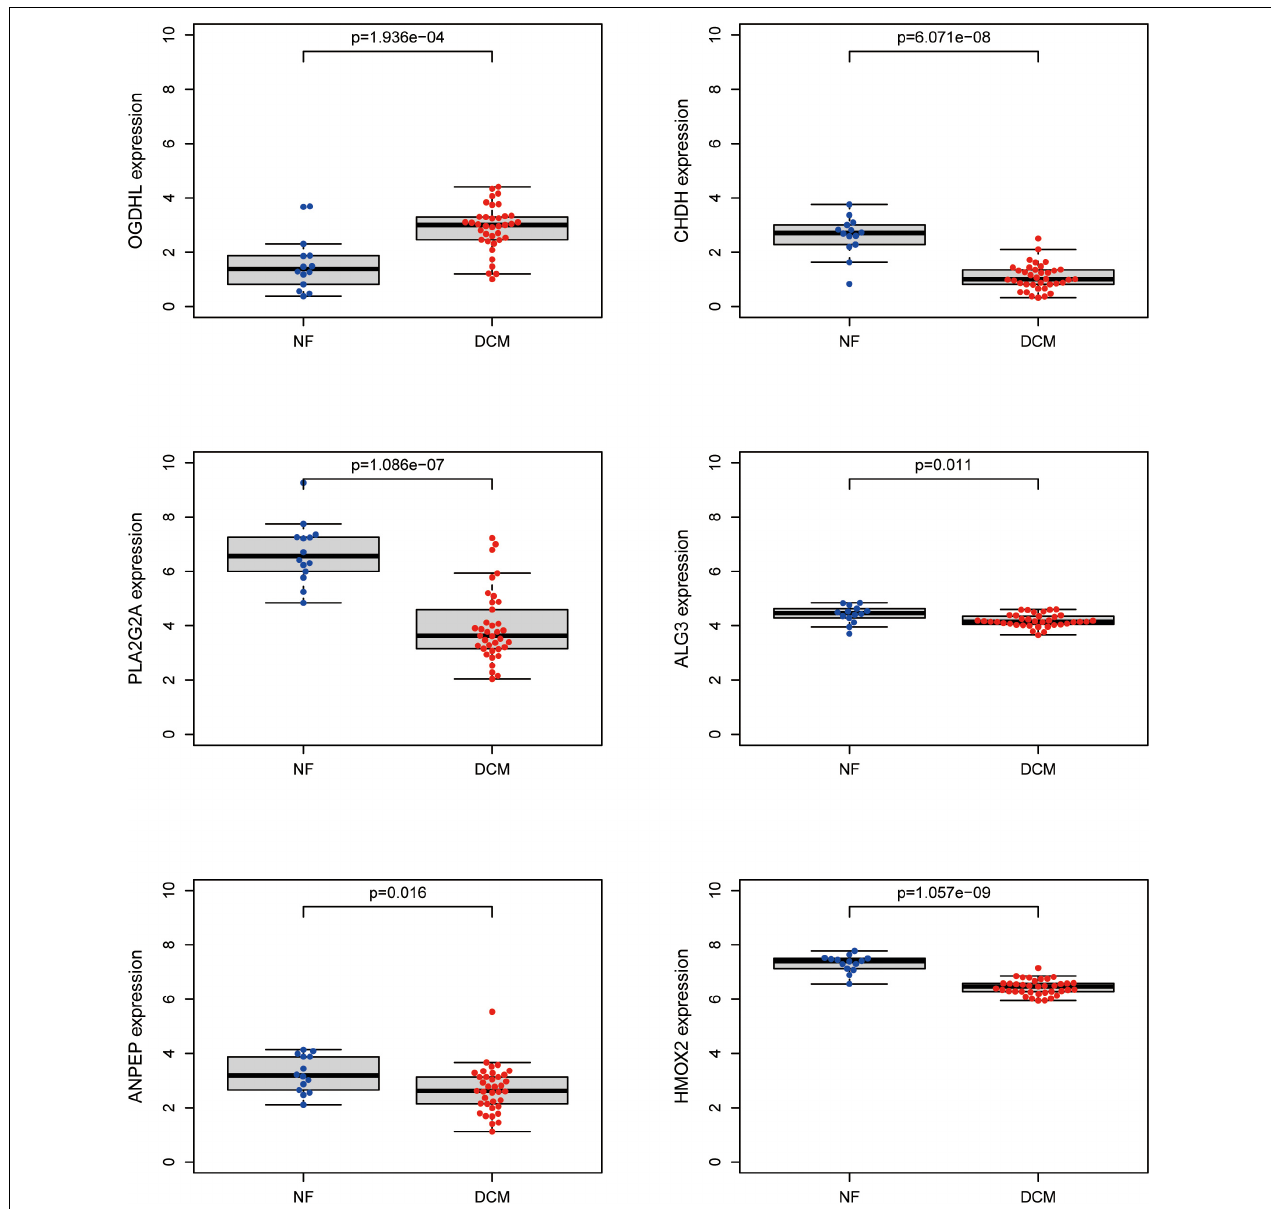
FIGURE 4 | Validation of expression level of key genes. The expression of the six key metabolism-related genes in the GSE116250 dataset.